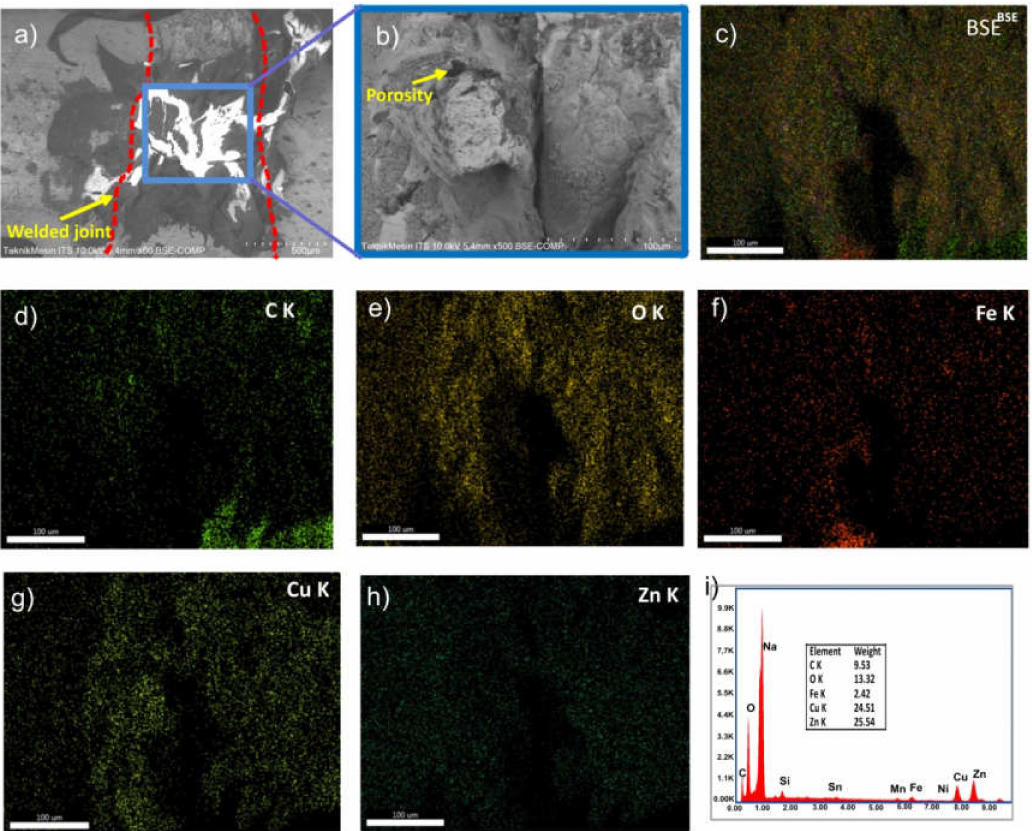
Figure 6. Micrograph of α 1 using SEM with ( a ) 50x magnification, ( b ) 300x magnification, ( c ) color composite of SEM / EDS maps (backscattered electron), ( d ) map of O, ( e ) map of C, ( f ) map of F, ( g ) map of Cu, ( h ) map of Zn using EDS, ( i ) Elements composition of welded